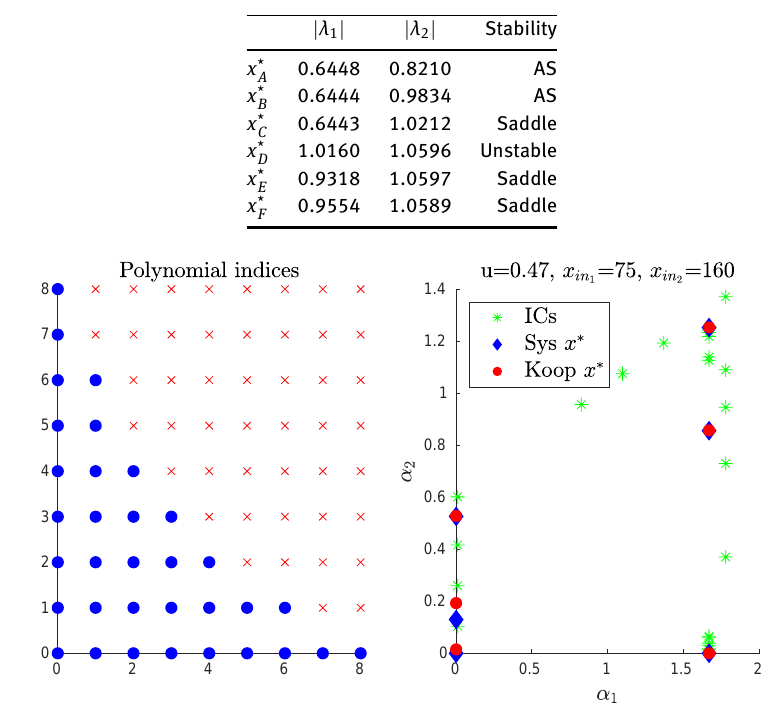
Figure 5: Location of fixed points in the state space from the solution of the minimization problem (26) from different initial conditions. present in the approximation. As a result, the eigenfunc- tion that gives an accurate classification is a near unitary, or a constructed